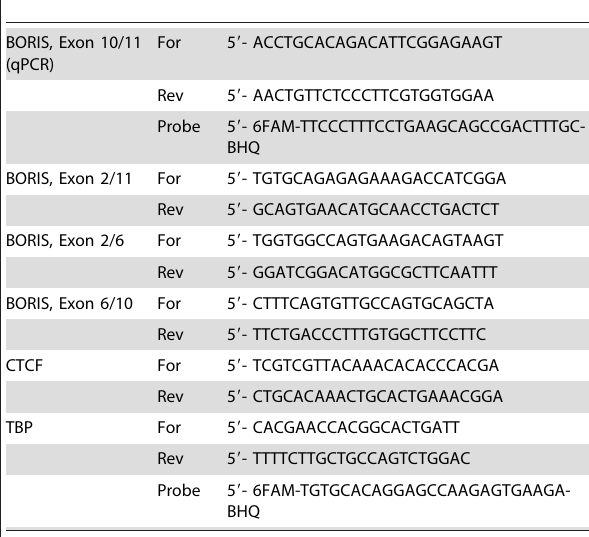
Table 2. Quantitative RT-PCR primer and probe